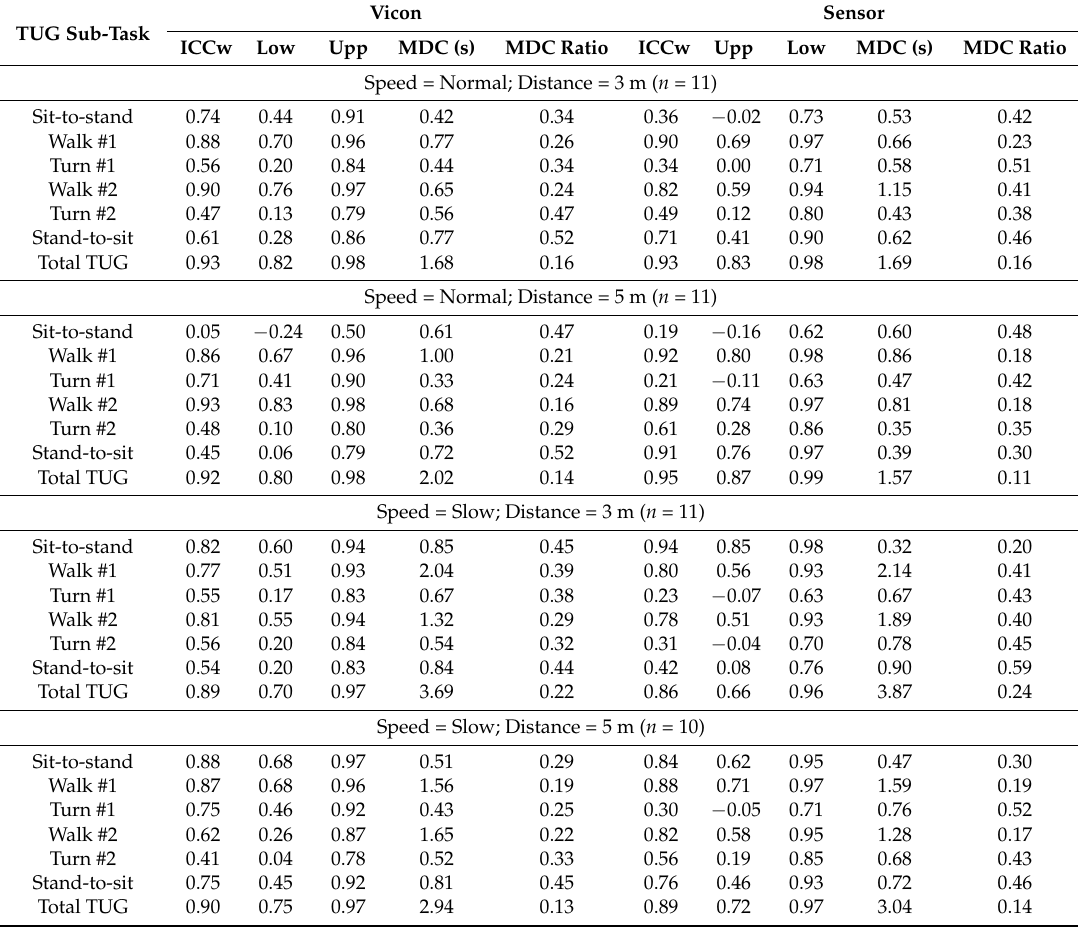
Table A2. Repeatability and minimal detectable change for marker-based (Vicon) and IMU-based (Sensor) sub-task